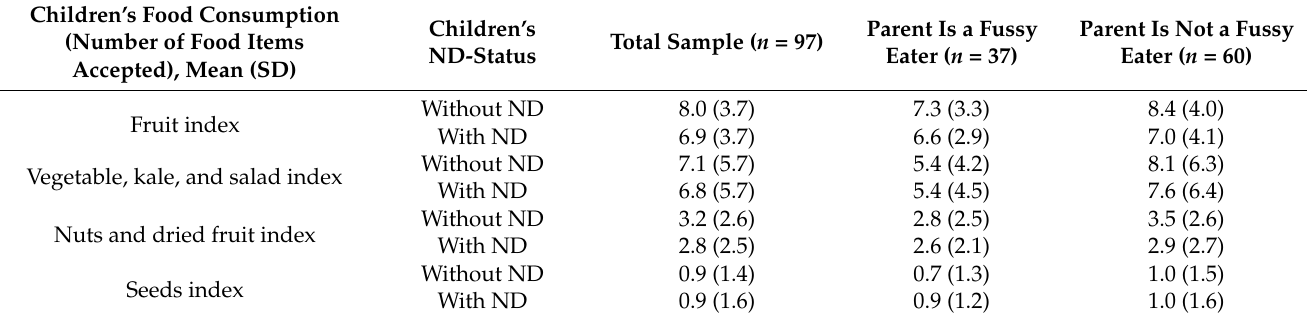
Table 3. Children’s food acceptance scores (number of food items accepted) for all food indices based on children’s ND-status, and parents’ fussy eating status. Results are presented as Mean (SD).